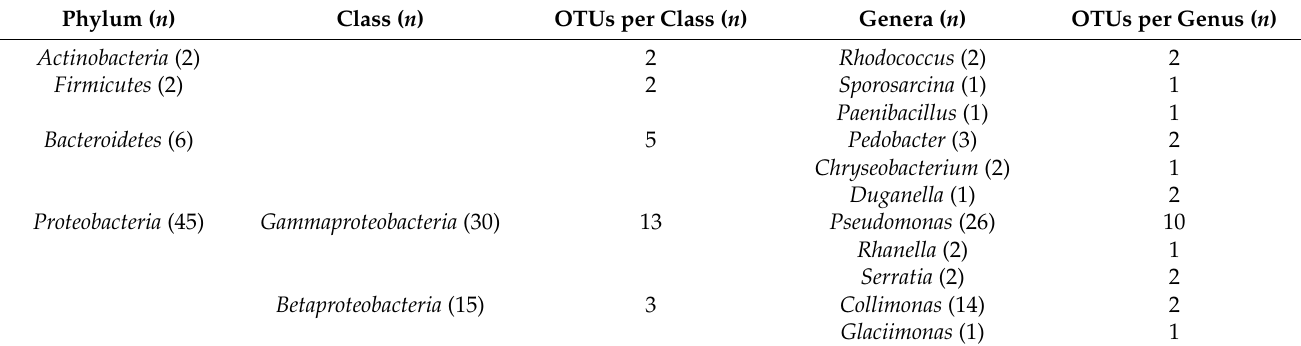
Figure 1. Phylogenetic relationship of the operational taxonomic units (OTUs) based on 16S rRNA gene sequences of the isolated strains and their reference species. Table 1. Identification of the 55 studied culturable bacterial strains ( n = number of